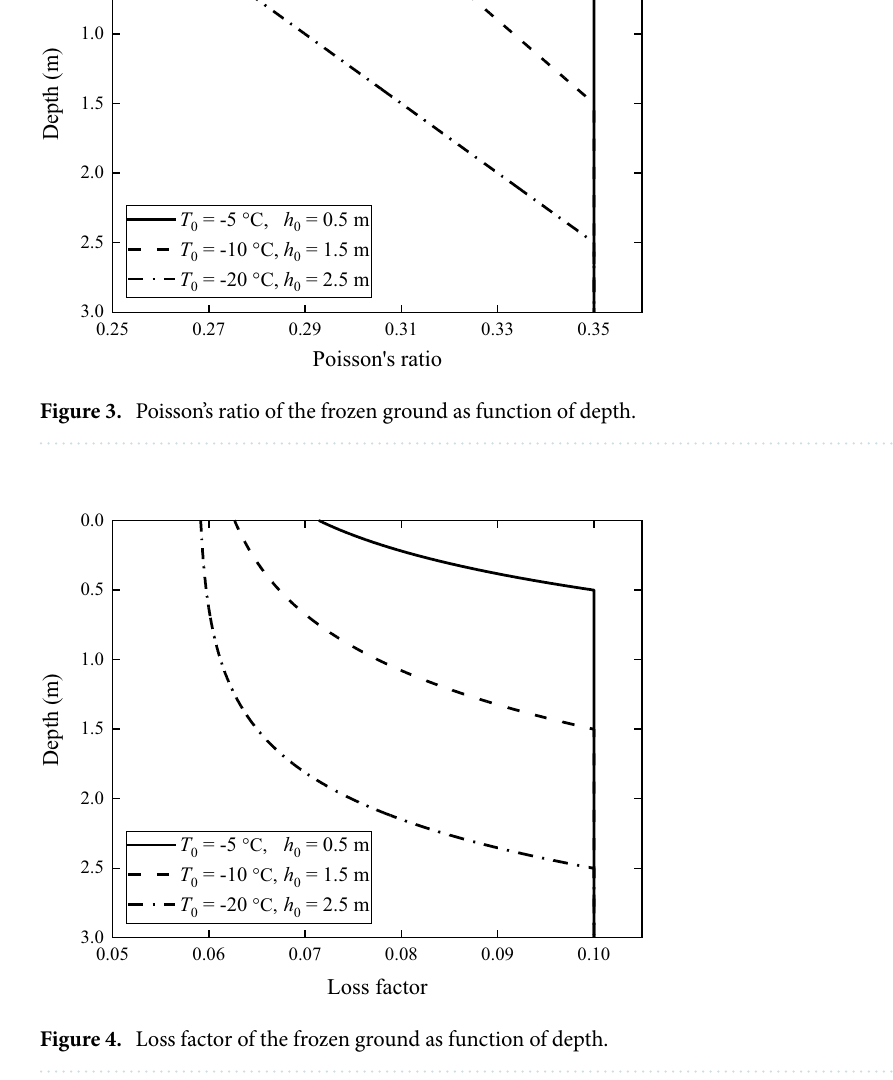
ground with different frozen temperatures can be determined . In order to verify the variation trends of soil material properties with temperature in Eqs. (2) and (3), the GDS bending element test system is used to measure the shear wave speed and shear modulus of frozen ground with different frozen temperatures, and the measured results are compared with those calculated by Eqs. (2) and (3). The operating principle of the GDS bending element test system can be laconically introduced through Fig. 6. The soil sample has two ends. During the test, the shear wave (sine wave) is emitted from the excitation terminal (one end of the soil sample) and the vibration signal is measured at the receiving terminal (the other end of the soil sample). Therefore, the propagation time t of the shear wave in the soil sample is obtained according to corresponding times, t 1 and t 2 , of the first wave crests of signals measured at excitation terminal and receiving